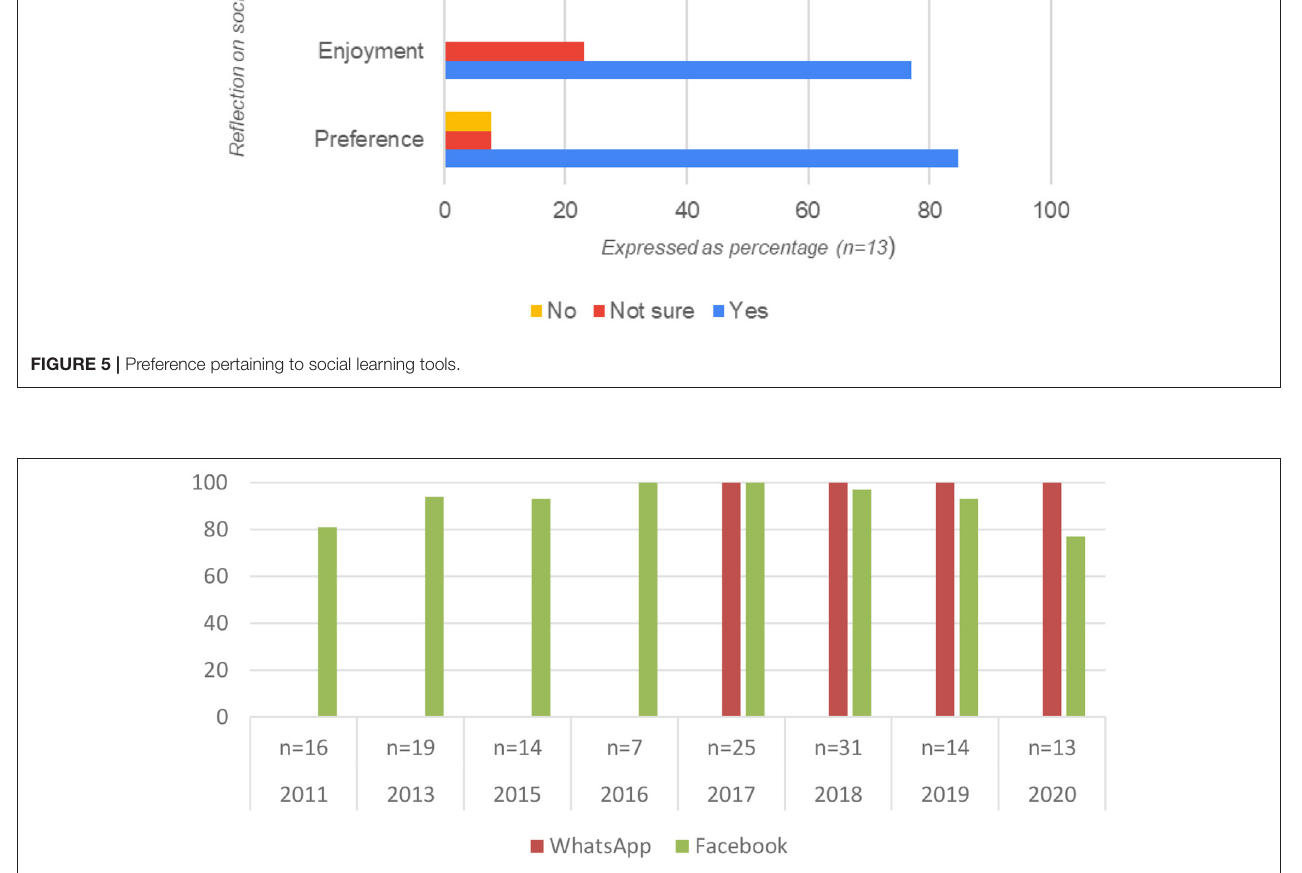
FIGURE 6 | Access to social media platforms over the 10-year